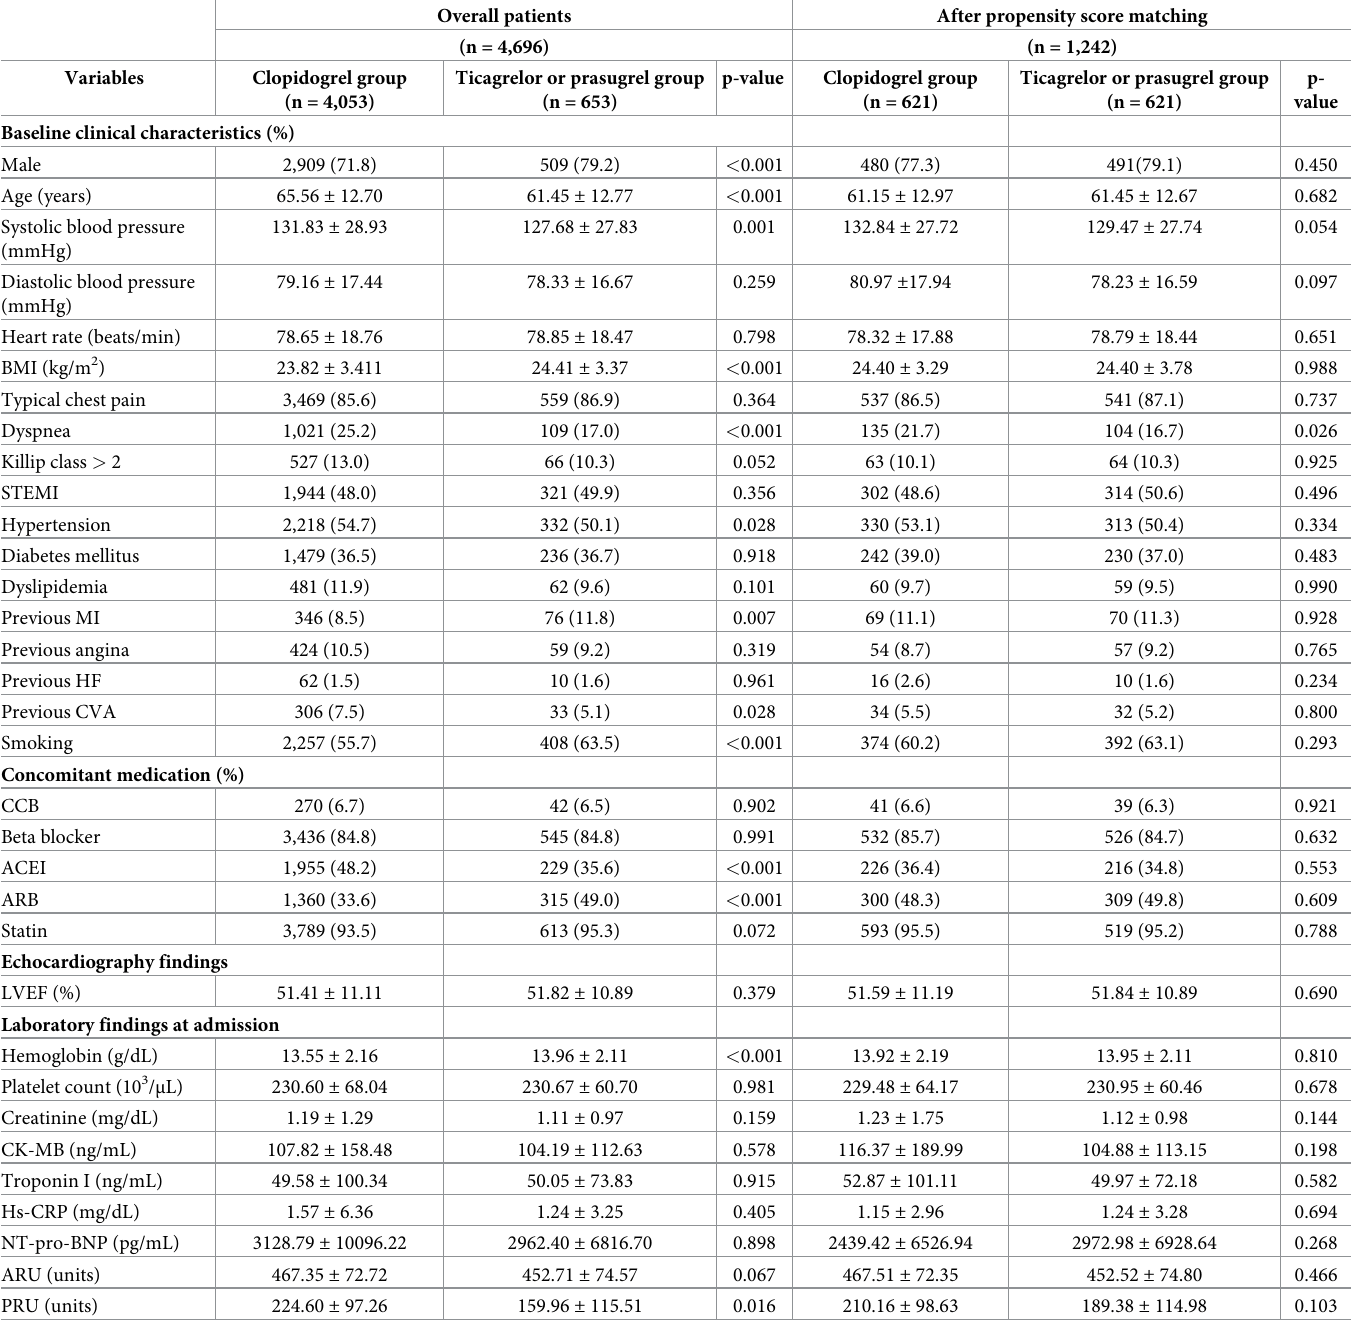
Table 1. Clinical characteristics of the clopidogrel and ticagrelor or prasugrel